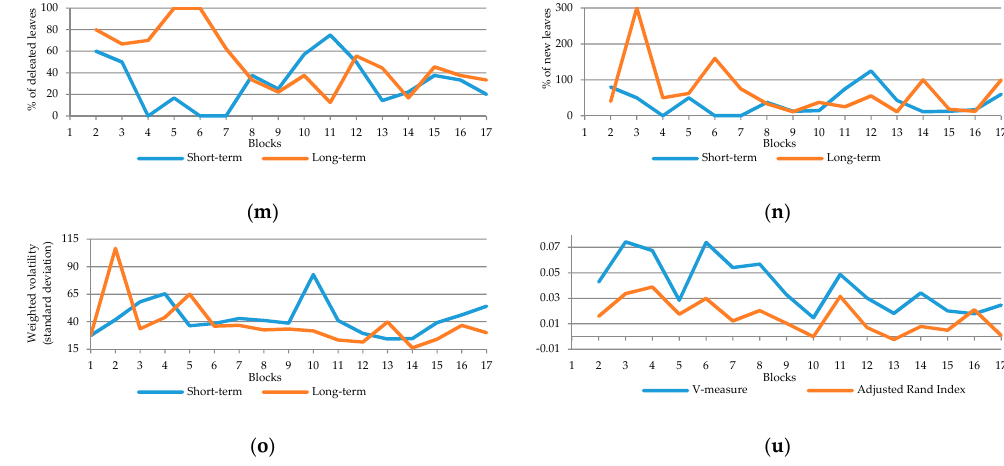
Figure 6. Detailed results for 𝑚𝑖𝑛𝑆𝑒𝑟𝑖𝑒𝑠 set at 5% and window length 𝑤 set at 30 days. Energies 2020 , 13 , x FOR PEER REVIEW